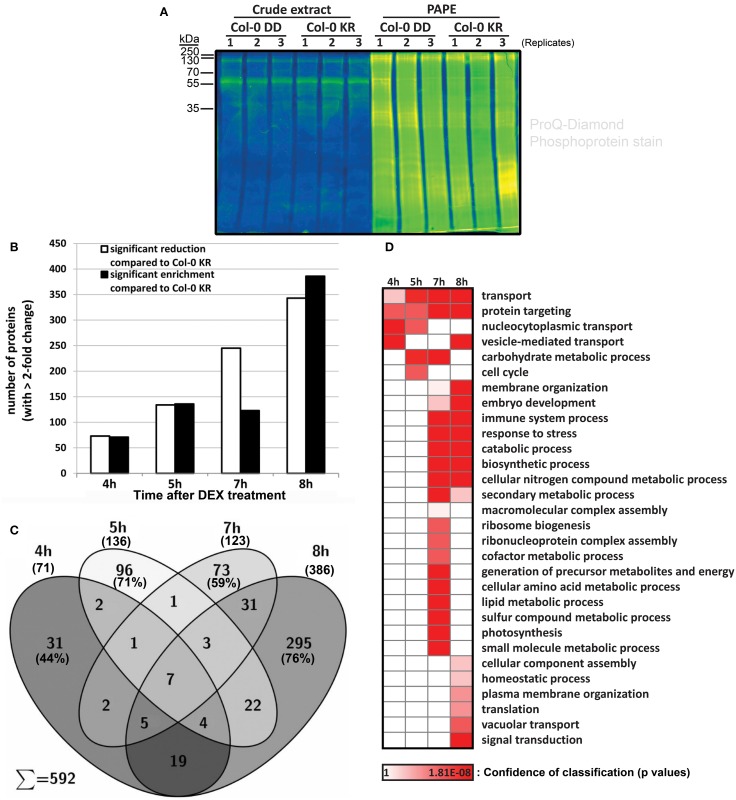
Isolation and identification of phosphoproteins with the prefractionation-assisted phosphoprotein enrichment (PAPE) method. Six week old plants of Col-0 DD and control (KR) were treated with DEX, harvested at different time points (4, 5, 7, 8 h) and subjected to PAPE procedure to isolate phosphoproteins. Analysis of these samples was performed with mass spectrometry and subsequent evaluation with Progenesis LC-MS. (A) Pro-Q Diamond phosphoprotein staining of ~10 μg of protein extracts before and after the PAPE procedure. The samples from the 5 h treatment were used exemplarily to illustrate the efficiency of the phosphoprotein enrichment through PAPE. (B) Number of proteins that showed a significant enrichment (black bars) or reduction (white bars) during PAPE compared to control plants (ANOVA p < 0.05 and maximum fold change of >2.0). (C) Venn diagram showing distribution of proteins with increased abundance (i.e., corresponding to black bars in B) during different time points after DEX treatment. (D) Enrichment of Gene Ontology (GO) biological process classifications in PAPE-protein extract for the putative phosphoproteins with increased abundance over the four time-points after DEX treatment. Annotation and calculation was done with STRING 9.05 (p-value with FDR correction <0.1, slim display). The confidence for the enrichment of the GO groups is indicated by the heat map of its p-value.